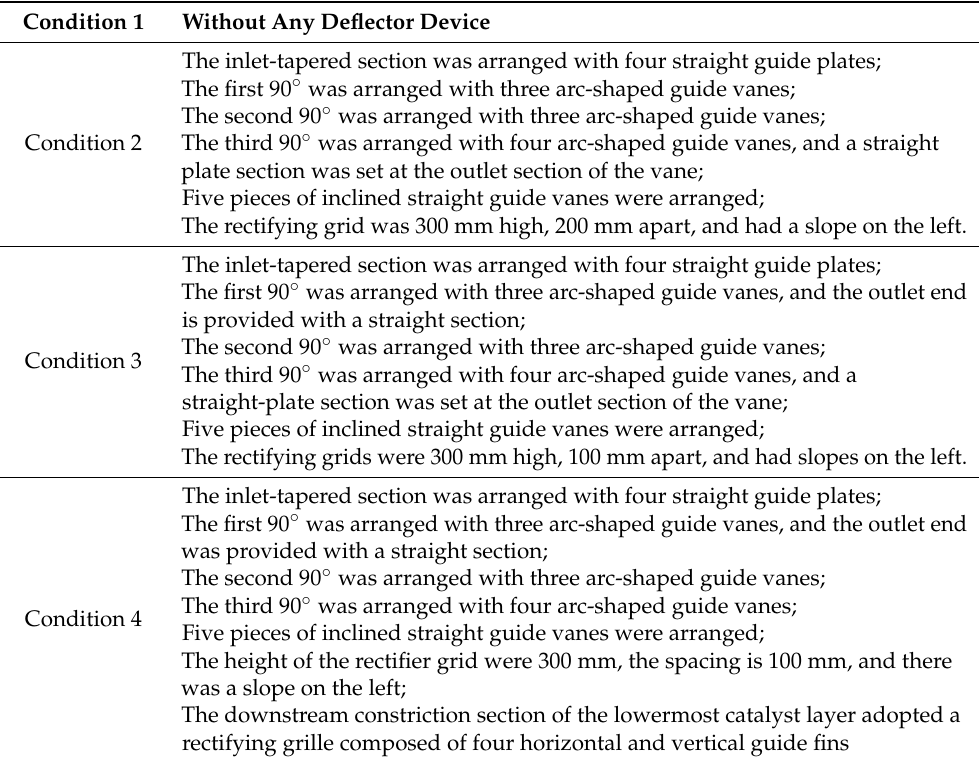
Table 4. Numerical simulation and optimization of SCR guide vane.